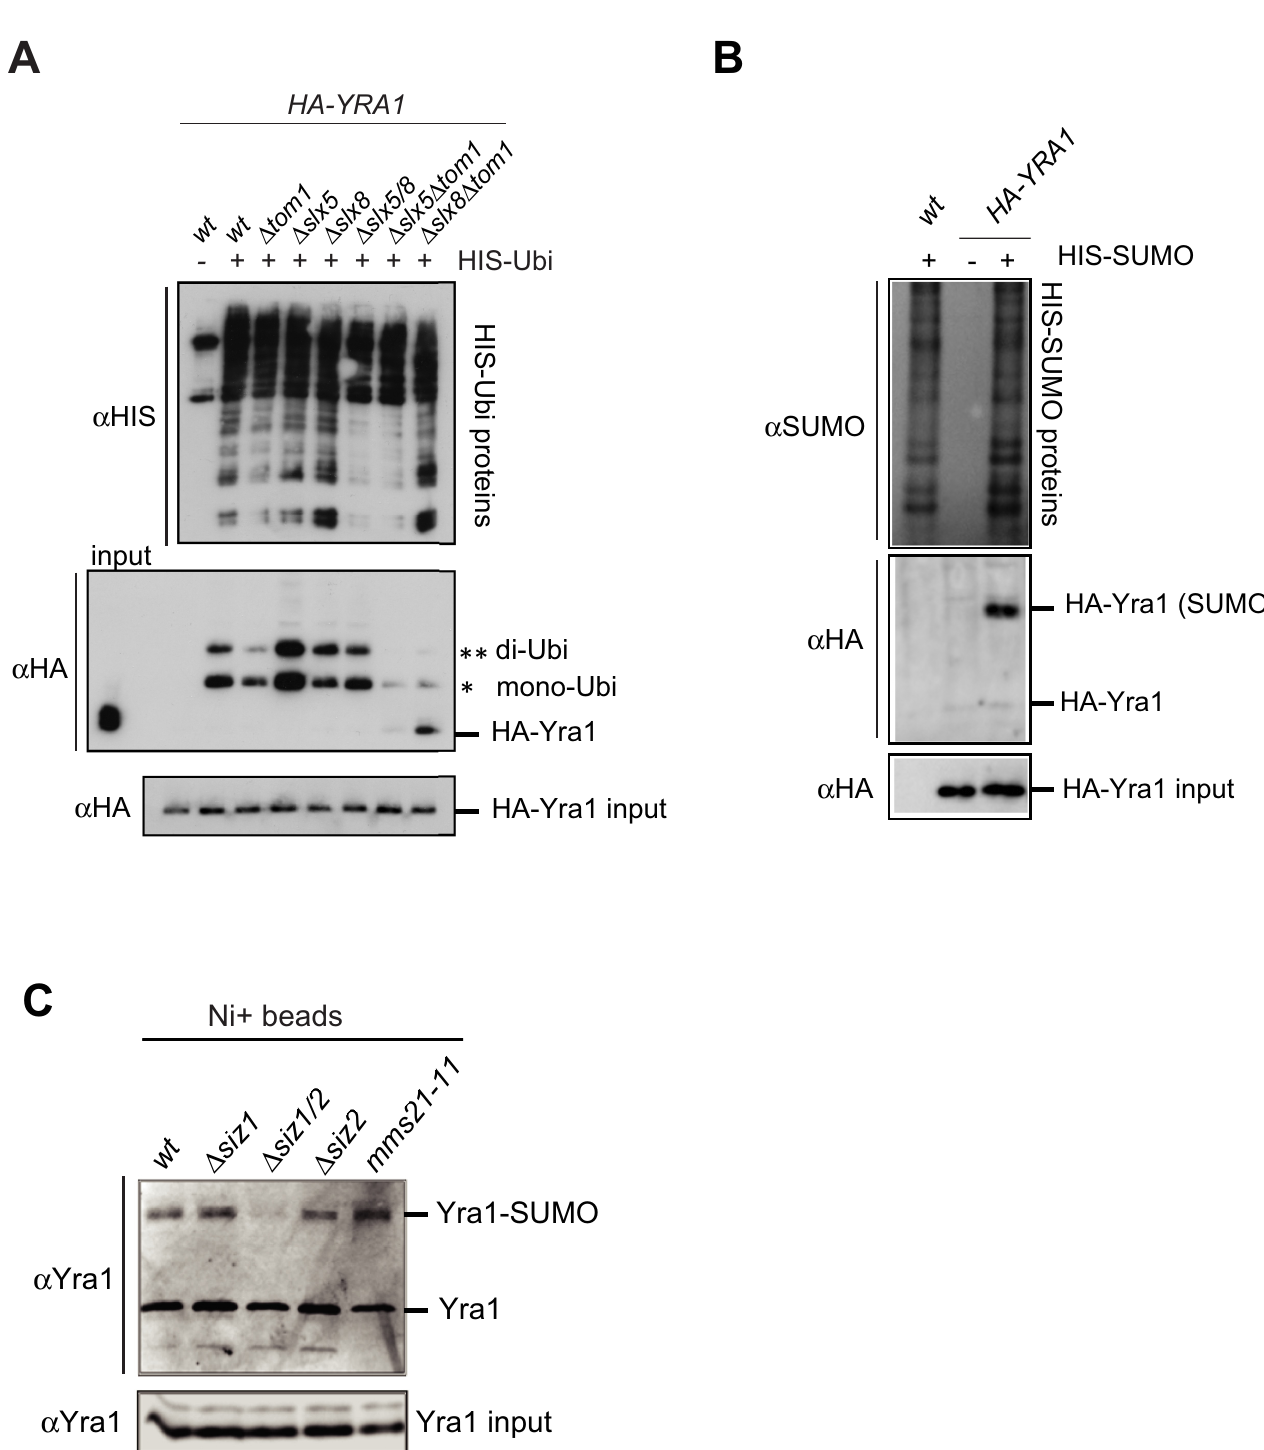
PLOS ONE | https://doi.org/10.1371/journal.pone.0206336 April 5,